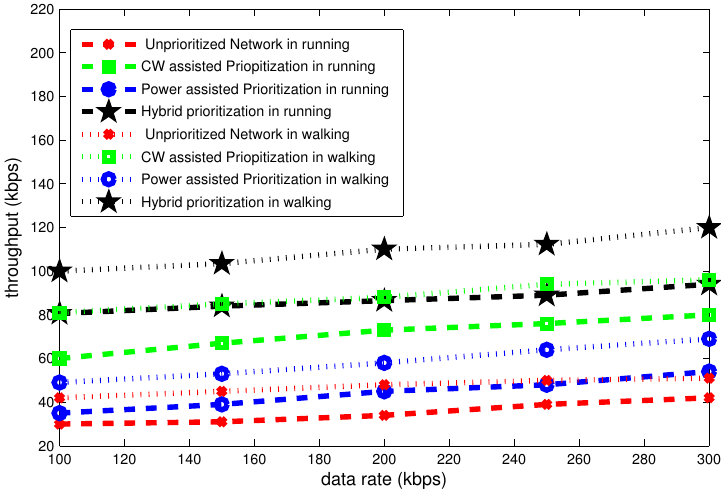
Figure 21. Effect of data rate on throughput in mobile postures.